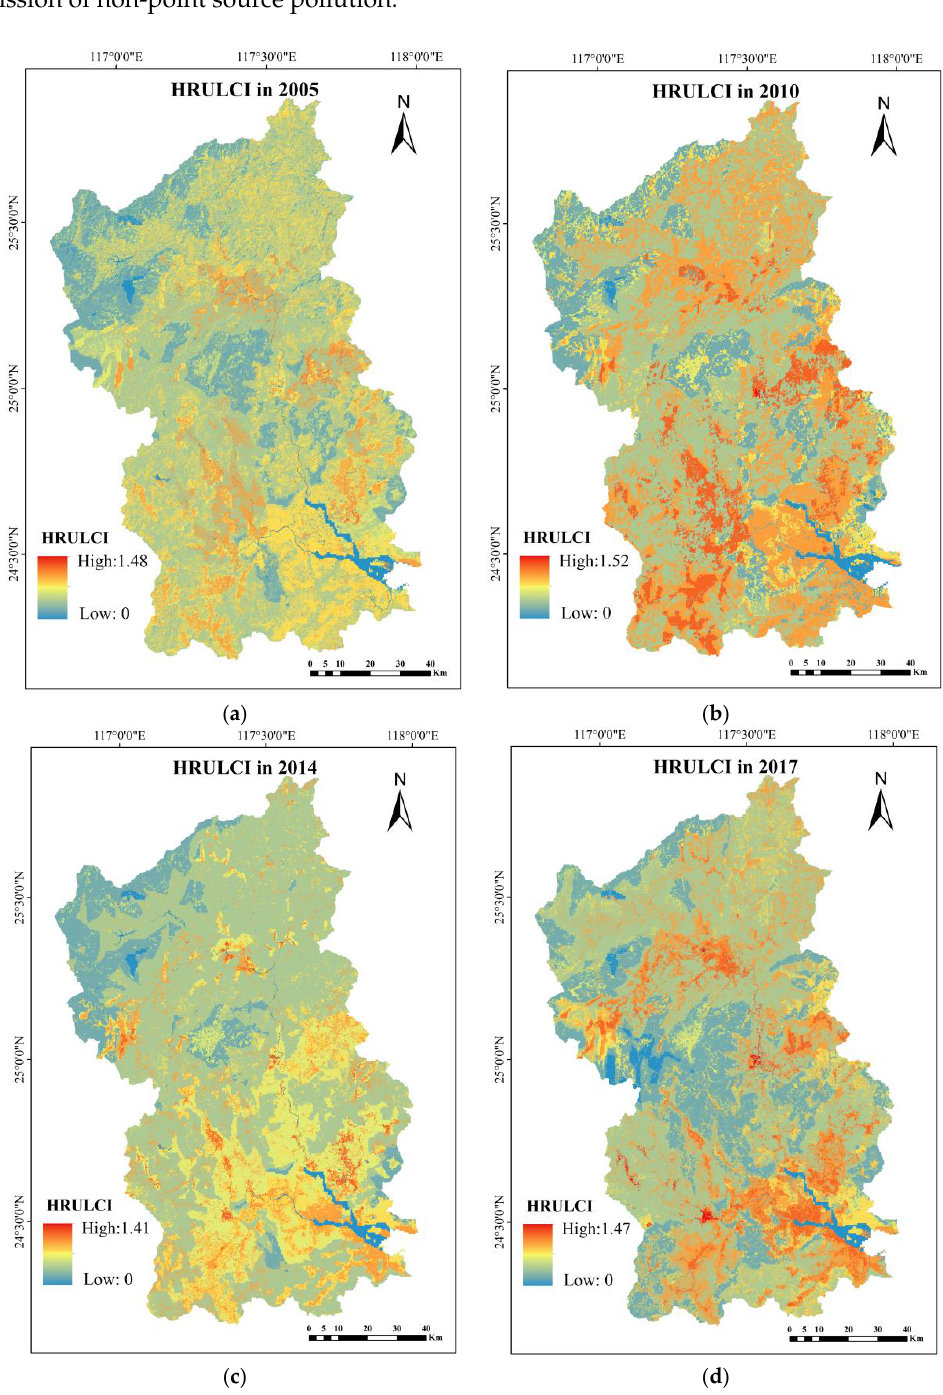
Figure 6. Location-weighted landscape contrast index computed on the basis of the minimum hydrological response unit (HRULCI) calculation results in Jiulong River basin. ( a ) HRULCI in 2005; ( b ) HRULCI in 2010; ( c ) HRULCI in 2014; ( d ) HRULCI in